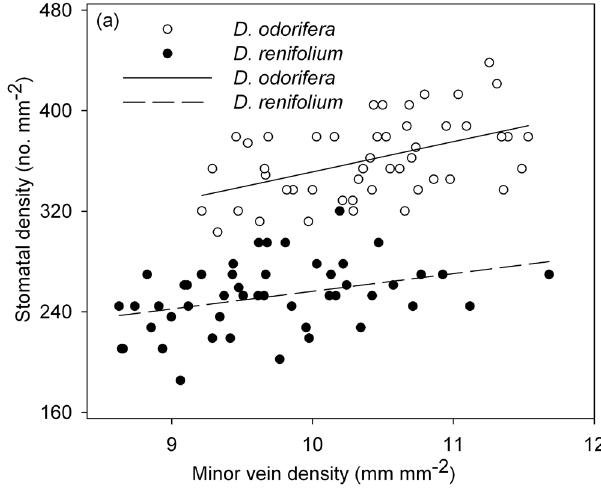
Figure 6. Relationships between minor vein density (MVD) and stomatal density (SD) for D . odorifera and D . renifolium . Each symbol represents one leaflet, and relationships were significant for each species ( D . odorifera , SD = 112.2 + 23.9 × MVD, r 2 = 0.23, P < 0.001; D . renifolium , SD = 115.7 + 14.1 × MVD, r 2 = 0.13, P <